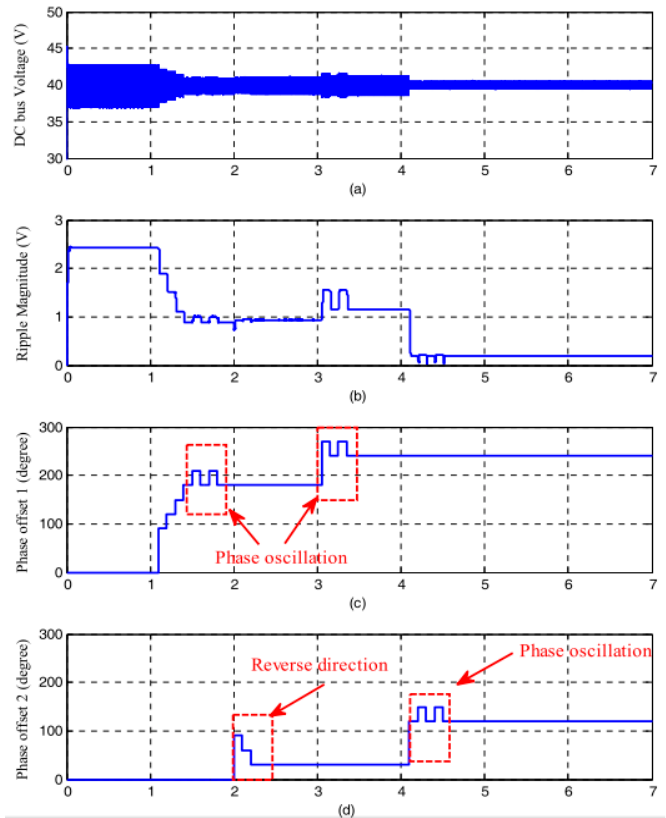
Figure 11. Case 1 simulation results for equal load sharing ( a ) DC bus voltage ripple; ( b ) Ripple Magnitude; ( c ) Converter 2 phase-offset; ( d ) Converter 3 phase-offset.